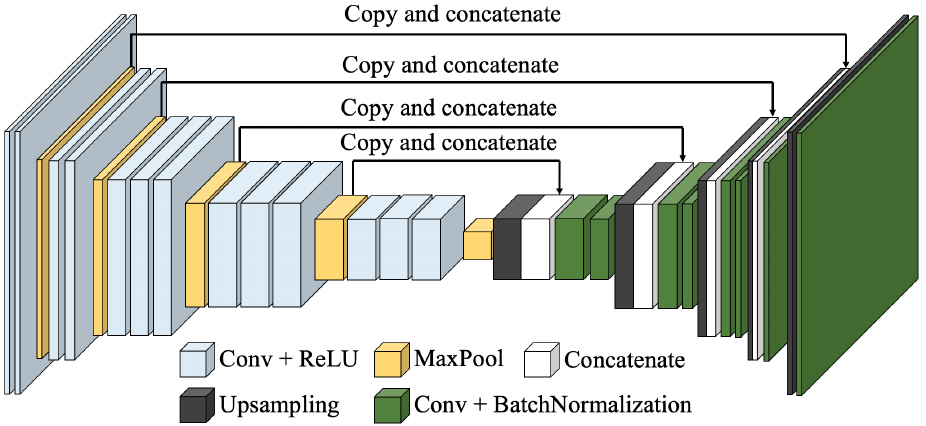
Figure 1. Overall architecture of VGG-Unet.